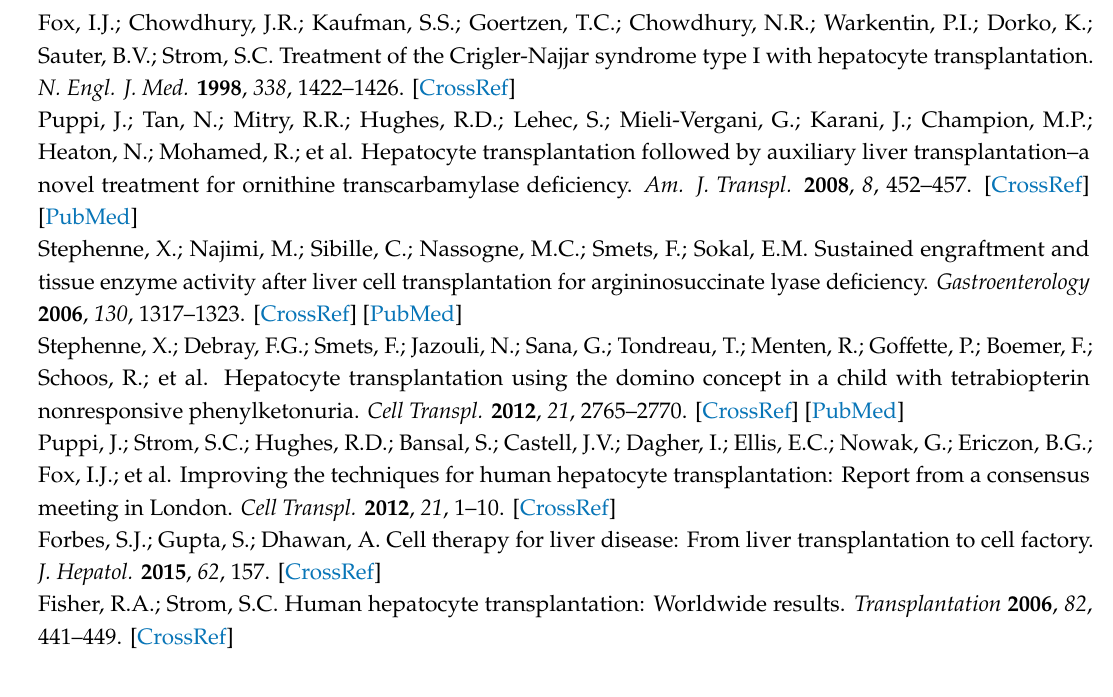
Figure S1: Gene expression profiling of expanding and di ff erentiated organoids, Figure S2: Intrahepatic injections of organoid-derived liver cells and fragmentse, Figure S3: Establishment and genetic correction of autologous canine liver organoid cultures, Figure S4: Controls for eGFP and van Gieson-elastica stainings, Figure S5: Determining minimum cell size for canine intraportal cell transplantation, Table S1: Dogs, transplantations and sampling moments, Table S2: Antibodies, antigen retrieval methods and chromogens used in single ICC / IHC and double IHC, Video S1: Video of dog after intraportal